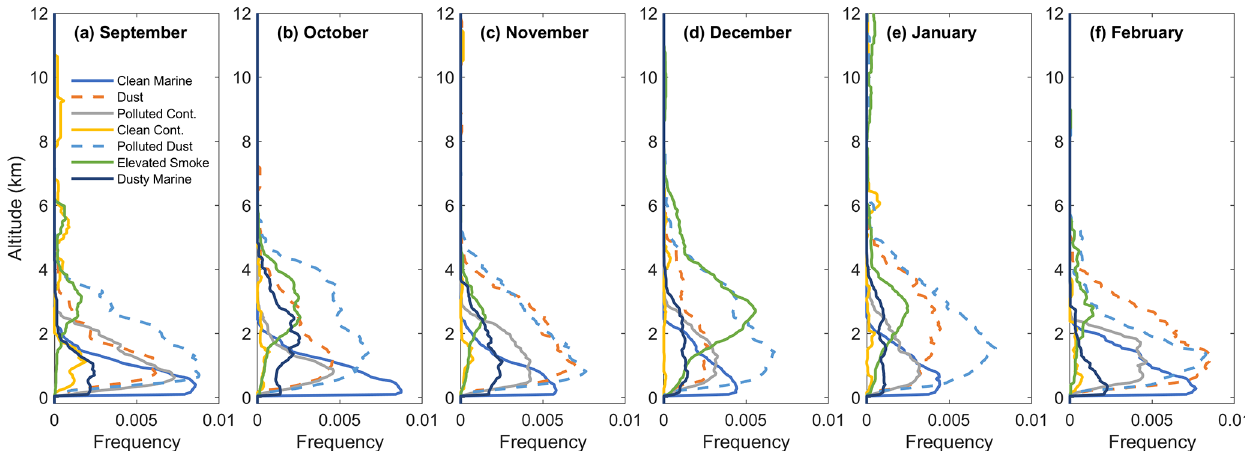
Figure 13. Occurrence frequency profile of each aerosol type during the period September 2019–February 2020 from CALIPSO L3 aerosol profile data product in southeastern Australia (the selected domain is the gray area over southeastern Australia in Fig. 1b).